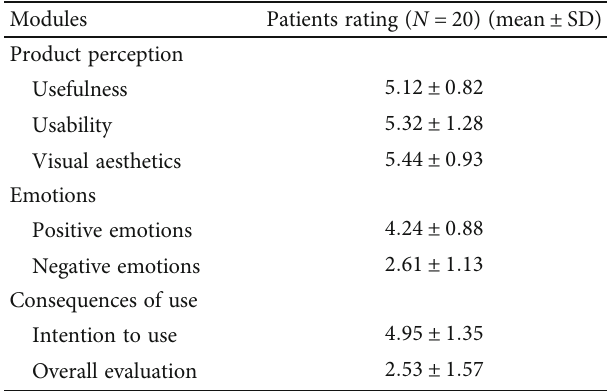
Figure 4: Comparison of the percentages of patients who achieved the minimal clinically important di ff erences (MCID) of the FMA- UE-M between groups after intervention.